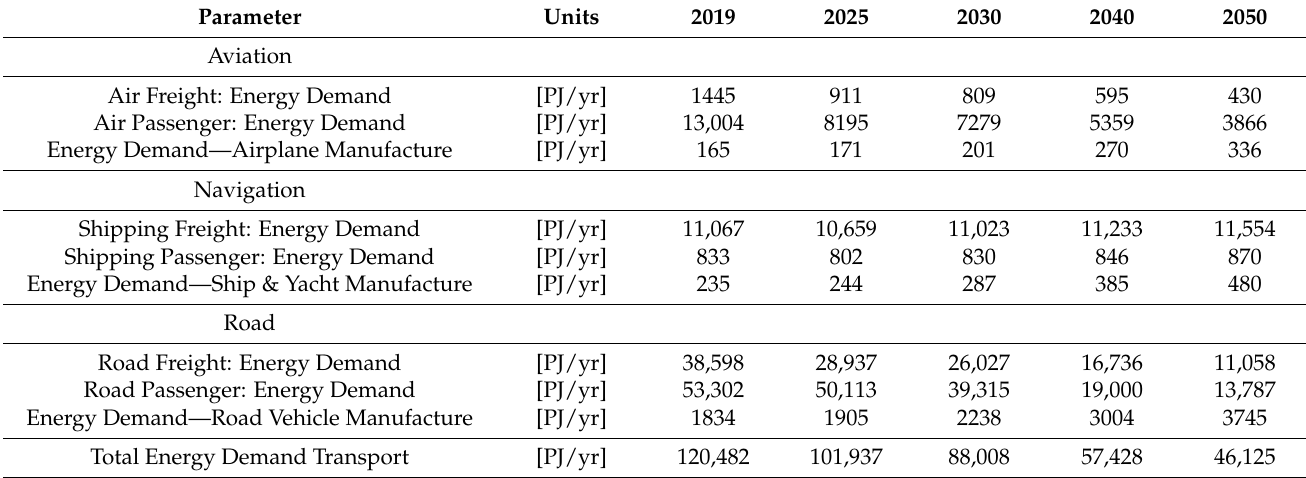
Table 18. Transport energy demand by transport mode under the OECM 1.5 ◦ C pathway.